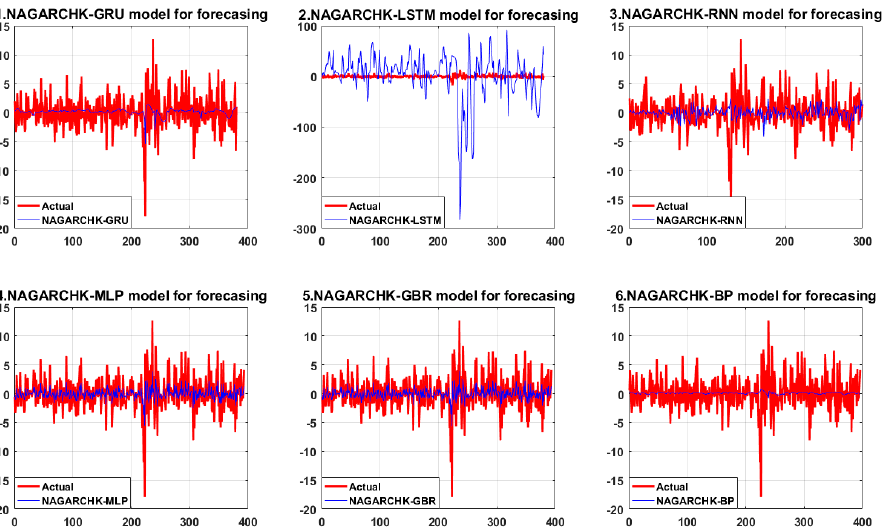
Figure 5. The forecasting performance of the proposed and benchmark models consider the feature of time-varying conditional variance and conditional kurtosis.